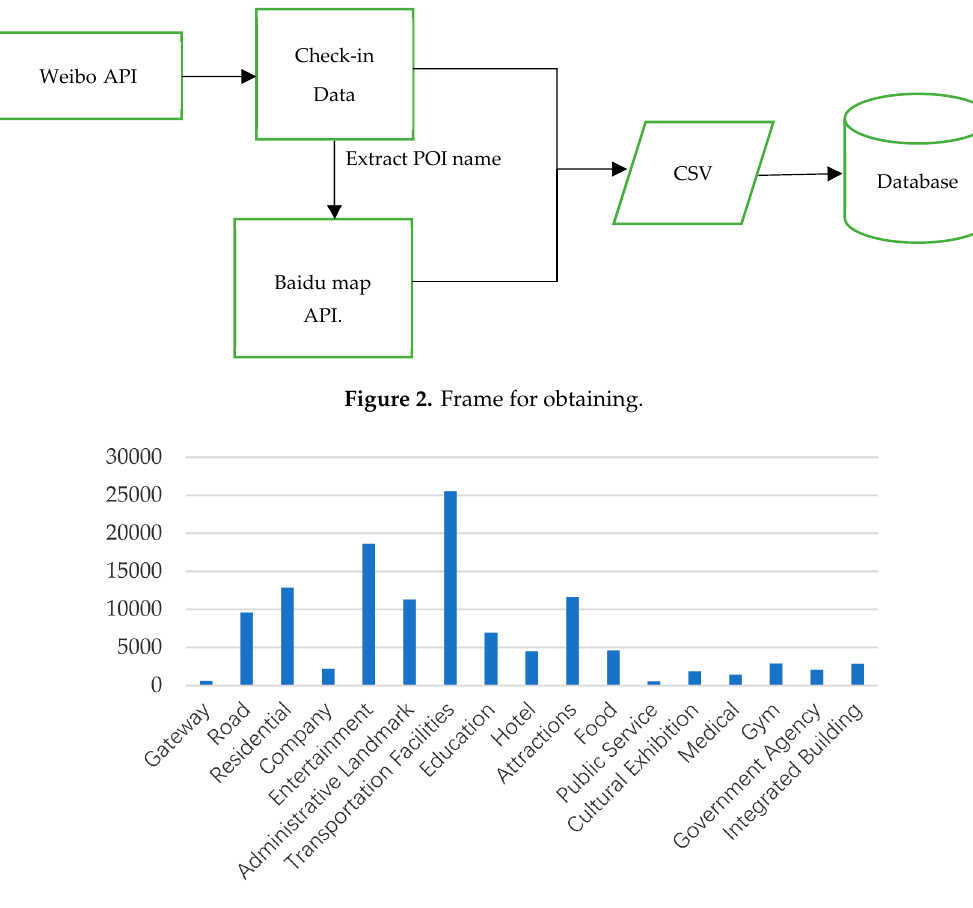
Figure 3. Quantities of various categories.